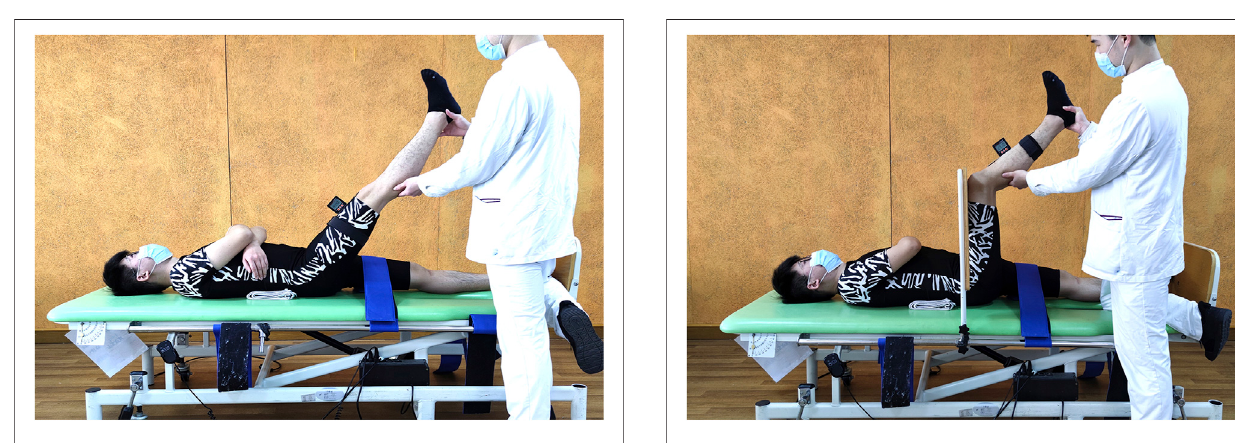
FIGURE 1 | Passive straight leg raise test. FIGURE 2 | Passive knee extension